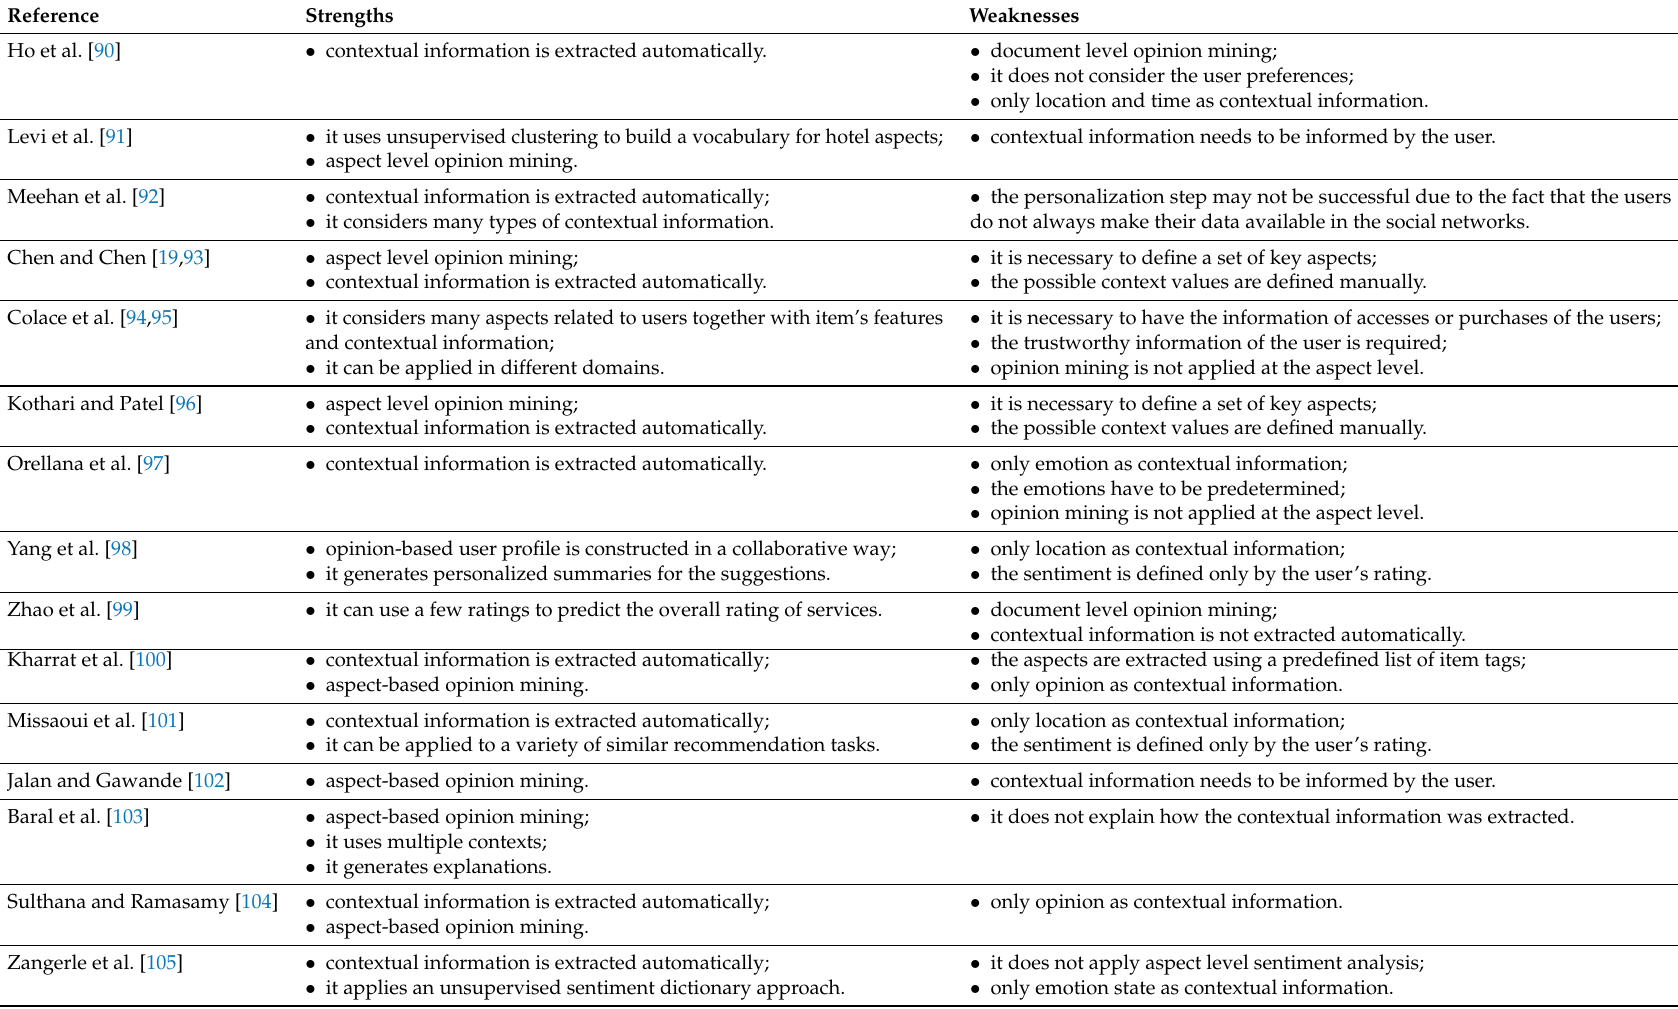
Table 5. Strengths and weaknesses overview of the studies analyzed in the systematic